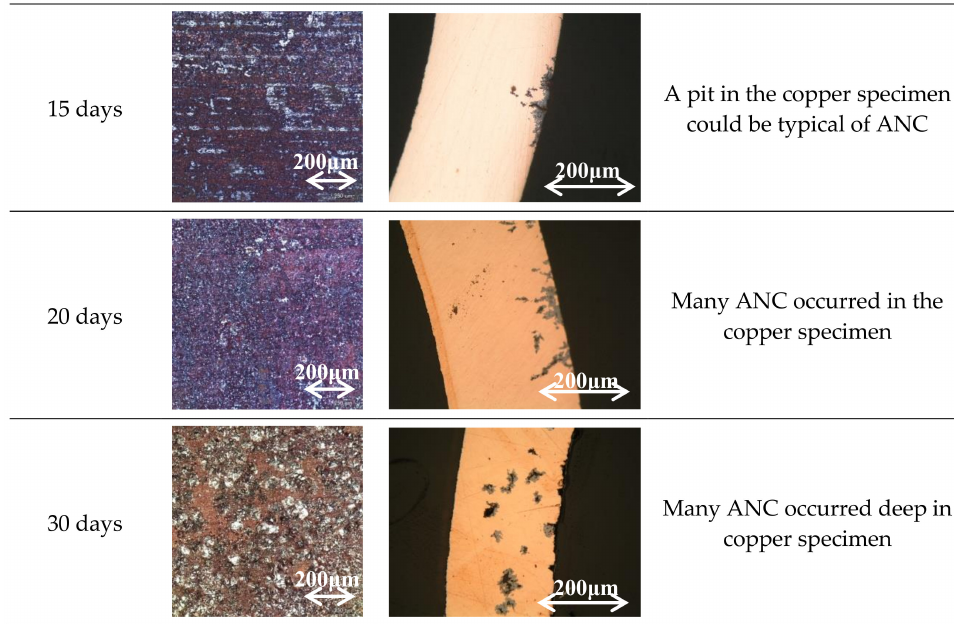
Figure 1. Surface and cross-section observations of Cu tube specimen immersed in 10 3 ppm Cu(HCOO) 2 .